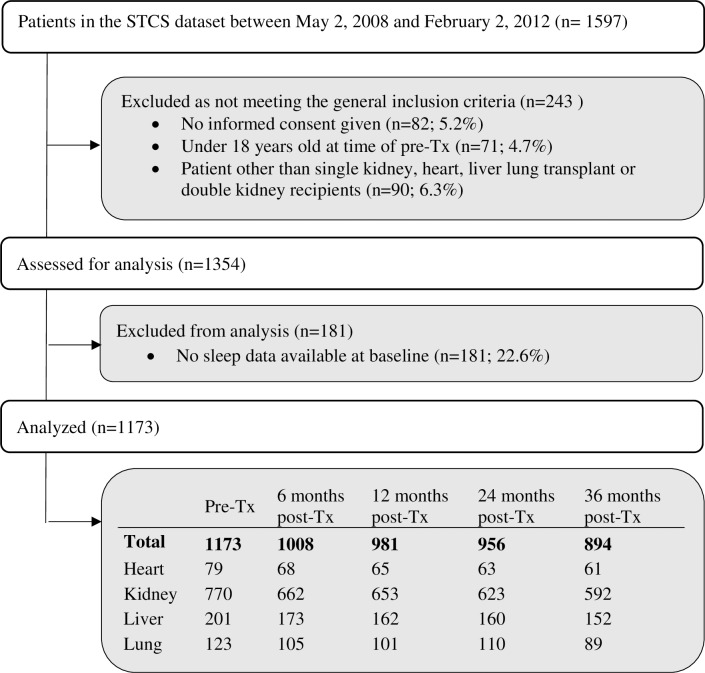
Flow diagram showing the sample as selected from the swiss transplant cohort study overall sample.